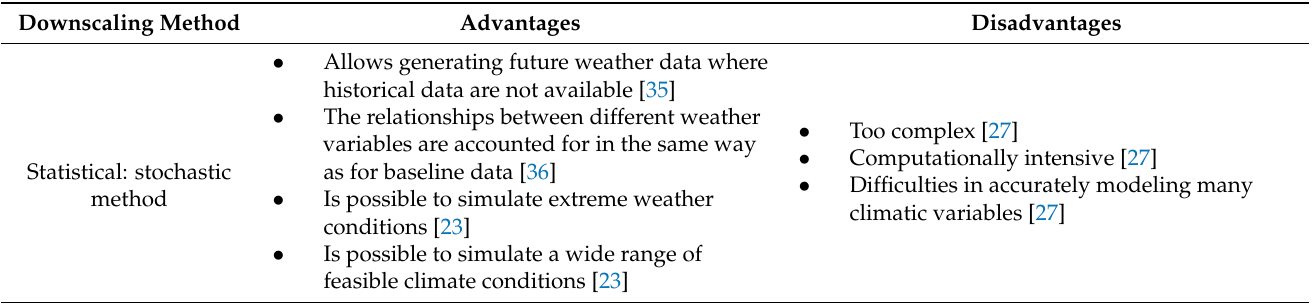
Table 2. Advantages and disadvantages of downscaling